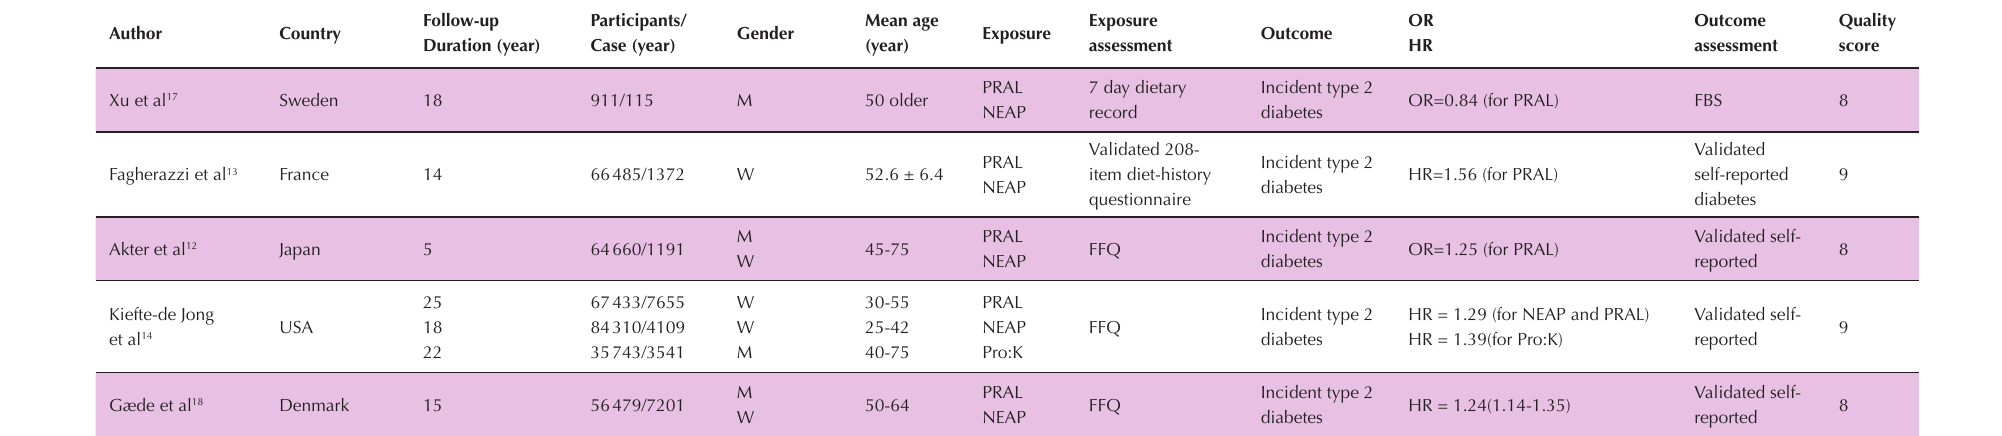
Table 1. Details of articles reviewed on the relationship between acid load and the incidence of